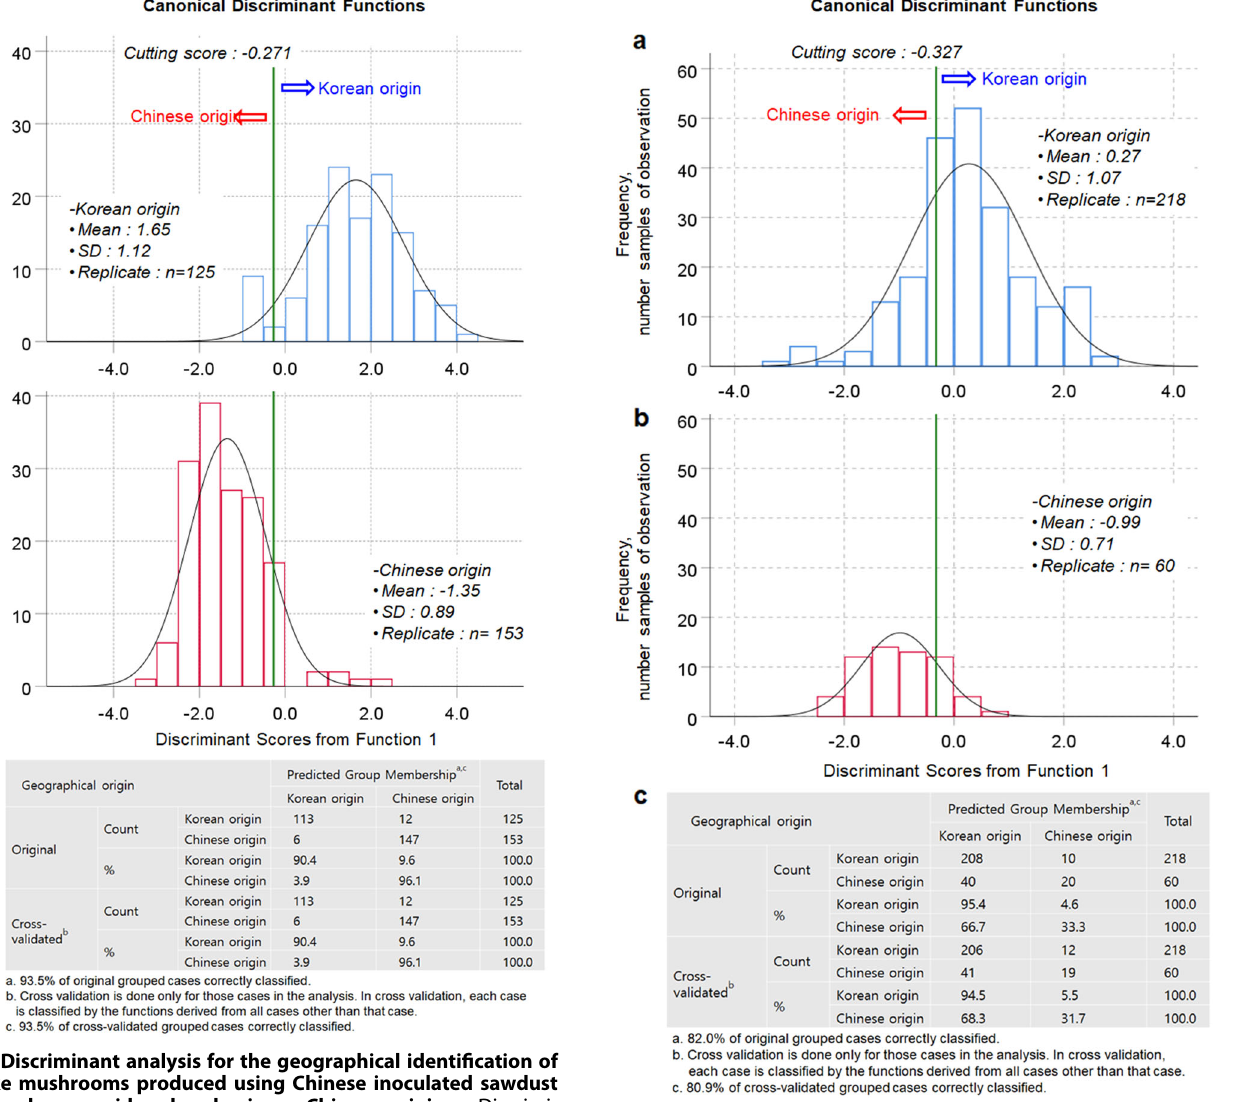
Fig. 5 Discriminant analysis for the geographical identi fi cation of shiitake mushrooms produced using Chinese inoculated sawdust blocks, when considered as having a Korean origin. a Discriminant scores for shiitake mushrooms with a Korean origin, b Discriminant scores for shiitake mushrooms with a Chinese origin, and c Classi fi cation and cross-validated results of the geographical origin of shiitake